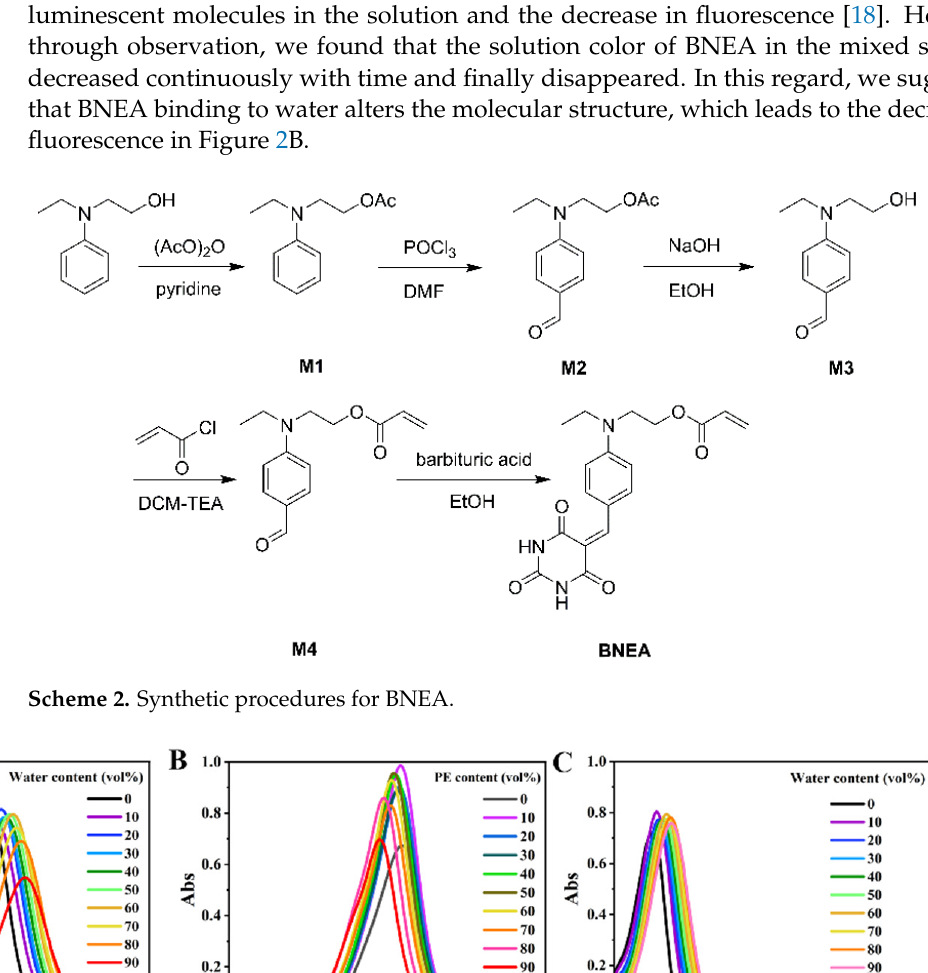
Figure 1. UV-vis spectra of ( A ) BNEA in THF-H 2 O mixture solution, ( B ) BNEA in DCM-PE mixture solution ([BNEA] = 20 μ M) and ( C ) M4 in THF-H 2 O mixture solution ([M4] = 20 μ M).